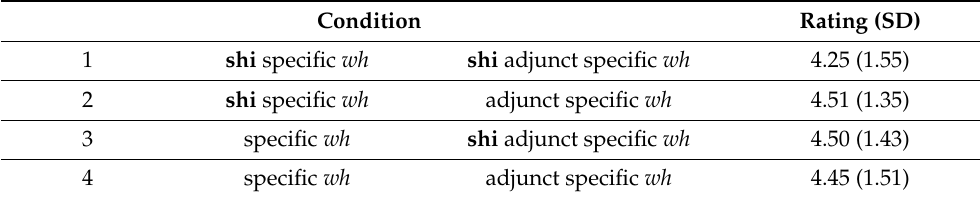
Table 15. Mean acceptability ratings in sub-experiment